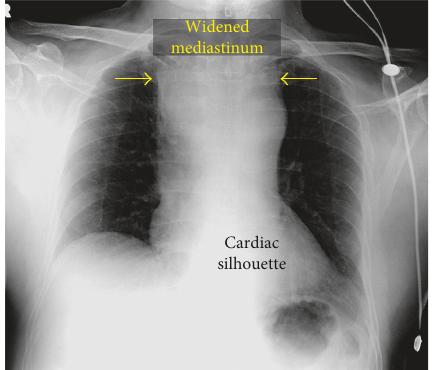
Figure 2: Chest radiography (AP orientation) demonstrating a widened superior